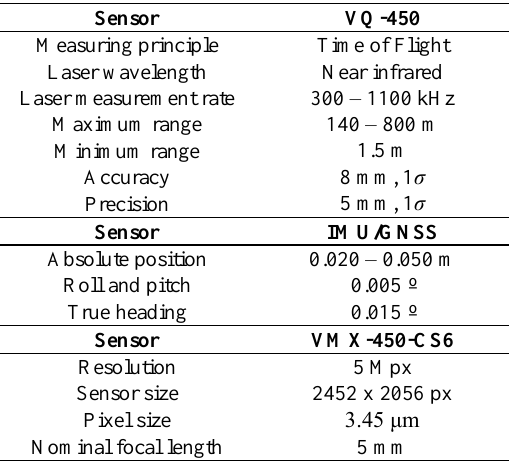
Table 1. Technical characteristics of the RIEGL VMX-450 system according to the